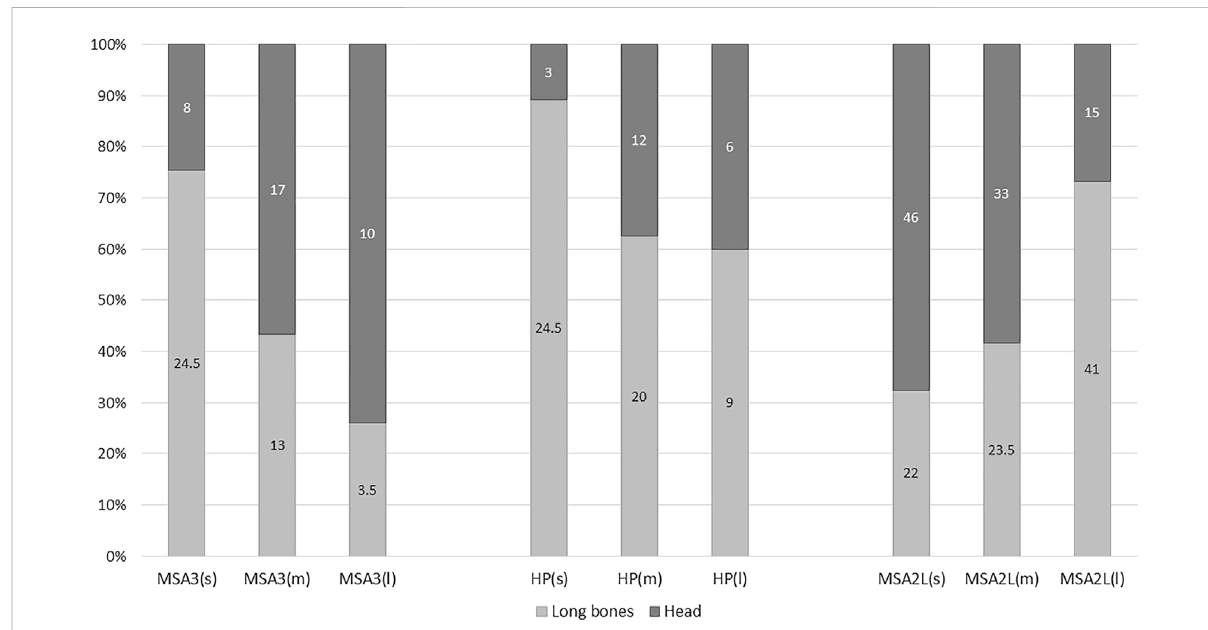
FIGURE 4 Head versus long bone distribution patterns for small (s), medium (m) and large mammals (l) at Klasies River. Number of specimens in columns.